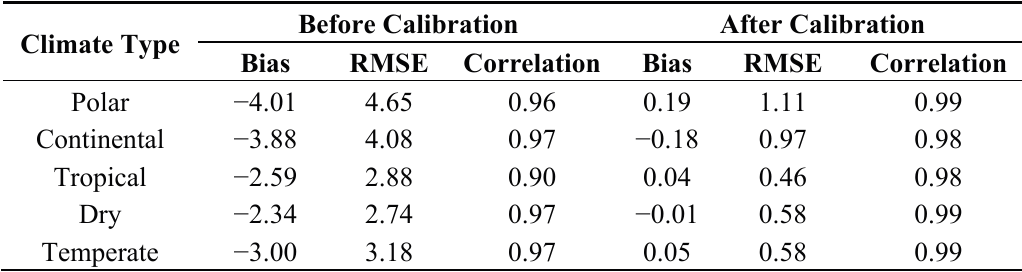
mean biases (Unit: Kelvin), Table 4. Summary of sensor ascending (PM) orbit T b Root Mean Square Error (RMSE) differences and Correlation Coefficients across all frequencies and polarizations estimated from overlapping AMSR and MWRI records calibration for five regions representing major Köppen-Geiger global before and after T b climate classification